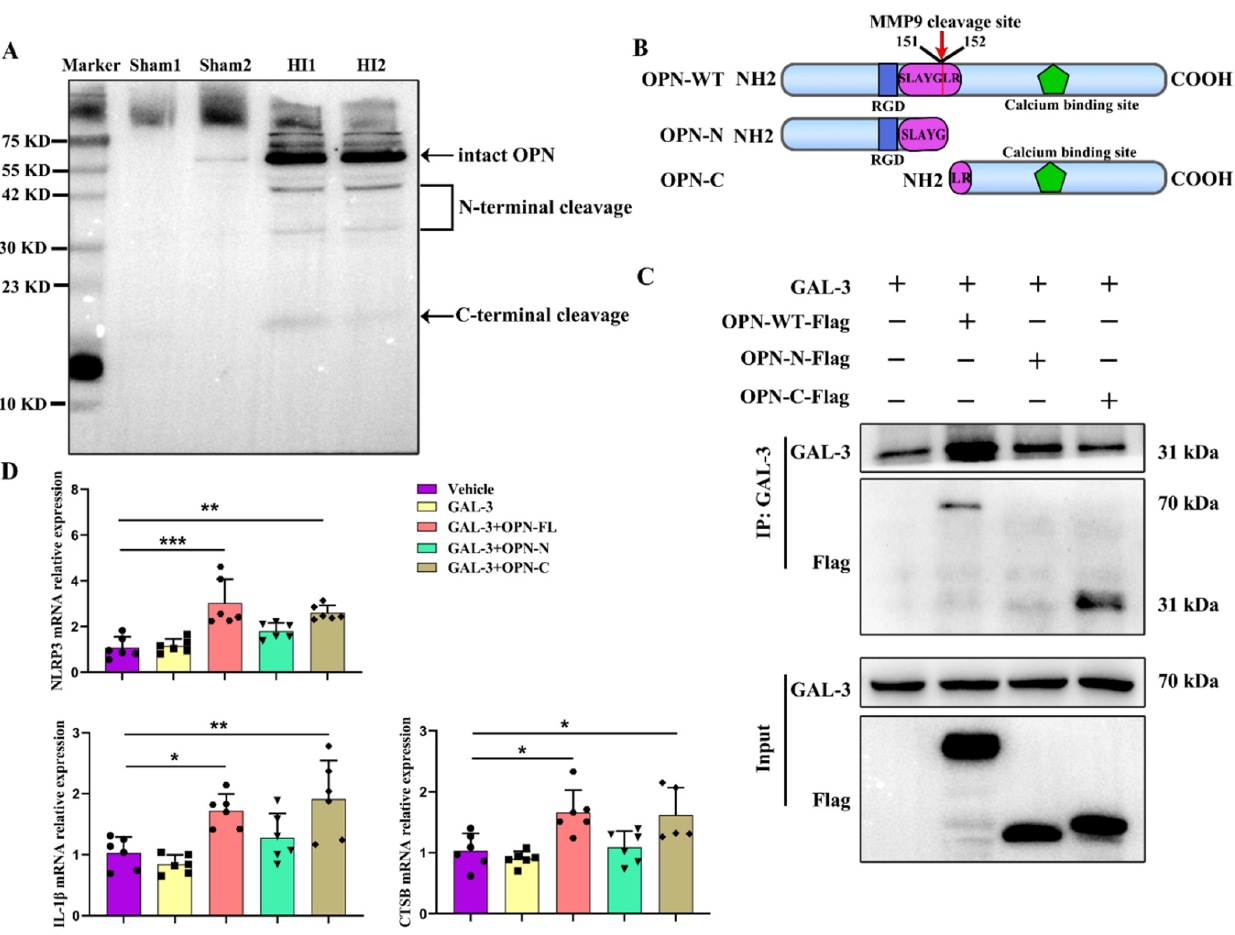
Figure 6. Cleaved OPN promotes lysosomal damage by interacting with GAL-3. ( A ) Western blot analysis of OPN in the ipsilateral cortex at 3 d using anti-OPN antibody. All experiments were per- formed three times ( n = 4). ( B ) Truncated versions of OPN shown schematically, including N-terminal fragment and C-terminal fragment. ( C ) Co-IP assays detecedthe interaction of GAL-3 with OPN-WT- Flag, OPN-N-Flag, and OPN-C-Flag. All experiments were performed three times. ( D ) NLRP3, IL-1 β , and CTSB mRNAs were assessed by qRT-PCR ( n = 6). Values represent the mean ± SD, * p < 0.05, ** p < 0.01, *** p < 0.001 according to one-way ANOVA with Bonferroni corrections in ( D ). OPN-C, OPN-C-terminal fragment; co-IP, co-immunoprecipitation; CTSB, cathepsin B; GAL-3, galectin-3; HI, hypoxia–ischemia; IL-1 β , interleukin-1 β ; LAMP1, lysosomal-associated membrane protein 1; NLRP3, NOD-like receptor thermal protein domain-associated protein 3; OPN-N, OPN-N-terminal fragment; OPN, osteopontin; WT,